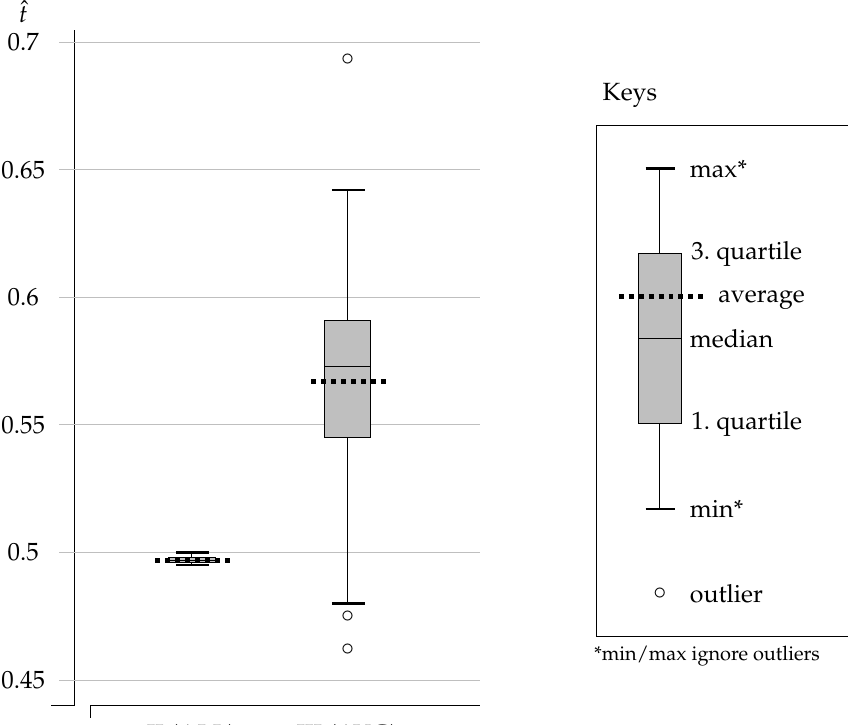
Figure 2. Boxplots for the shared threshold from Experiments II and